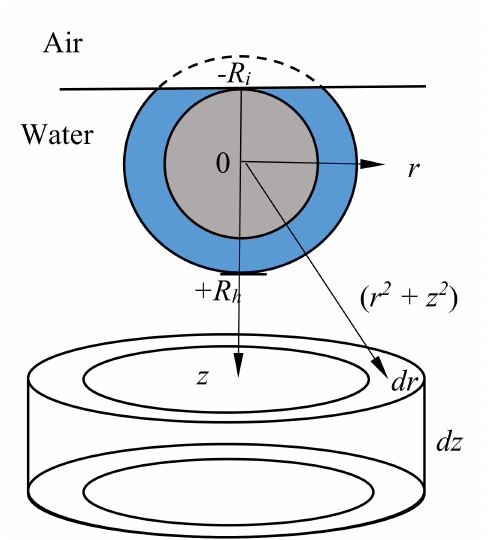
Figure A2. Illustration of the integration procedure applied to derive the energy of interaction of surface ion with the whole bulk of